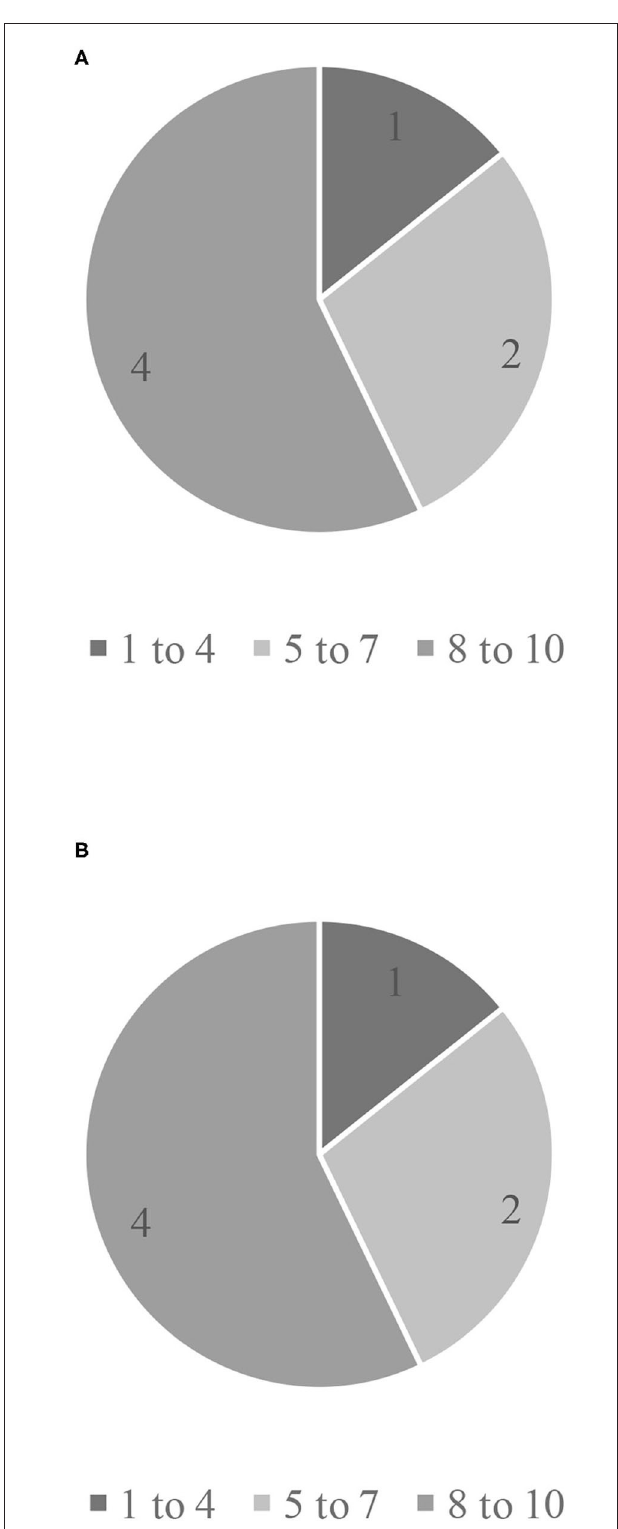
FIGURE 6 | Food businesses’ score (out of ten) for interest the alliance if it were based on either model: (A) Option A: single set of higher welfare standards or (B) Option B: tiers of welfare